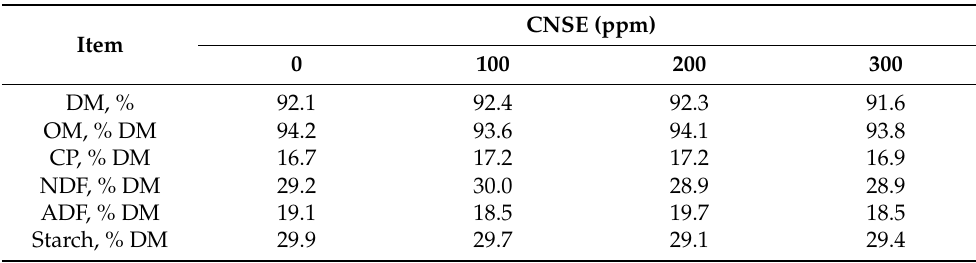
Table 2. Chemical composition of dietary treatment containing different levels of CNSE fed to continuous culture